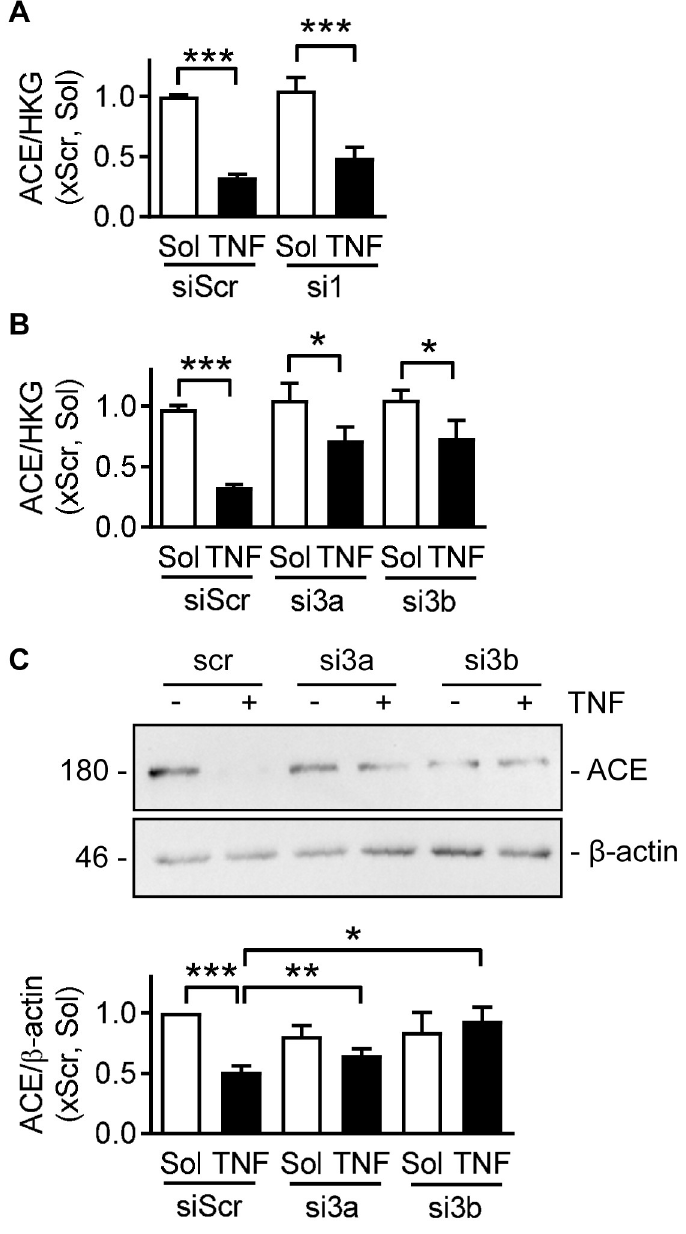
Fig 4. Involvement of DNMTs in TNF α -mediated alterations in ACE expression in human endothelial cells. (A) Consequences of DNMT1 downregulation (si1) on solvent (Sol) and TNF α (10 ng/mL, 24 hours)-induced changes in ACE mRNA relative to a triplet of housekeeping genes (HKG). A scrambled (Scr) oligonucleotide was used as control, n = 4–6 independent cell batches (two-way ANOVA/Bonferroni). (B&C) Consequences of DNMT3a (si3a) and 3b (si3b) downregulation on solvent (Sol) and TNF α (10 ng/mL, 24 hours)-induced changes in ACE mRNA (B) and protein (C) expression. A scrambled (Scr) oligonucleotide was used as control, n = 5–9 independent cell batches (two-way ANOVA/Bonferroni). � P < 0.05, �� P < 0.01, ��� P <